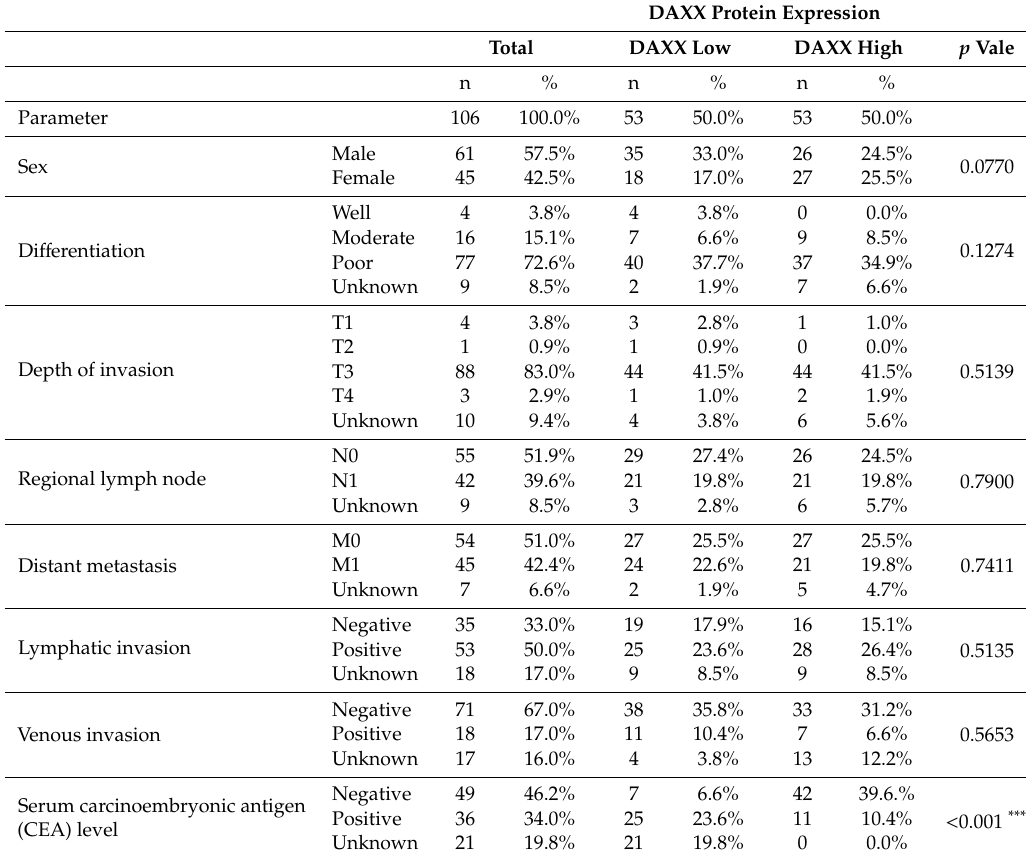
Associations between death domain-associated protein (DAXX) expression and clinicopathological characteristics of colorectal cancer